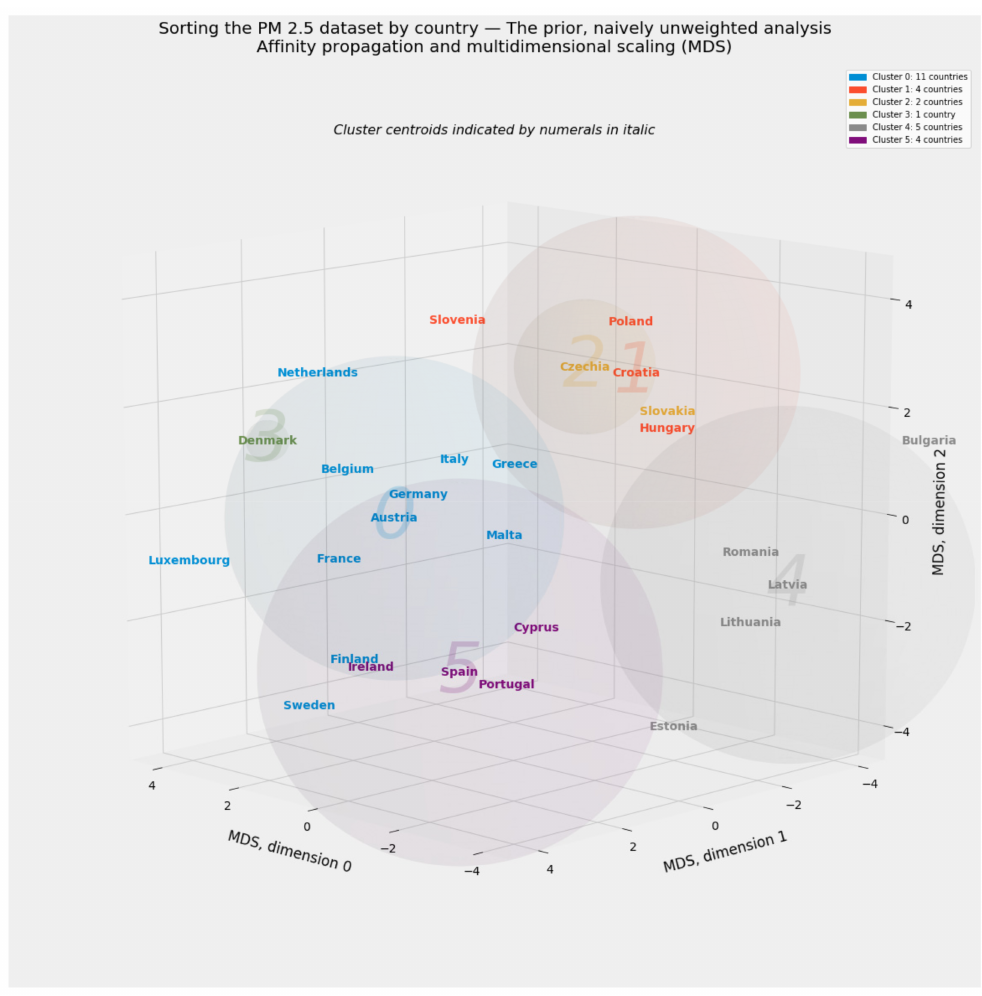
Figure 8. Clusters of EU countries based on naïve, unweighted country-level aggregate